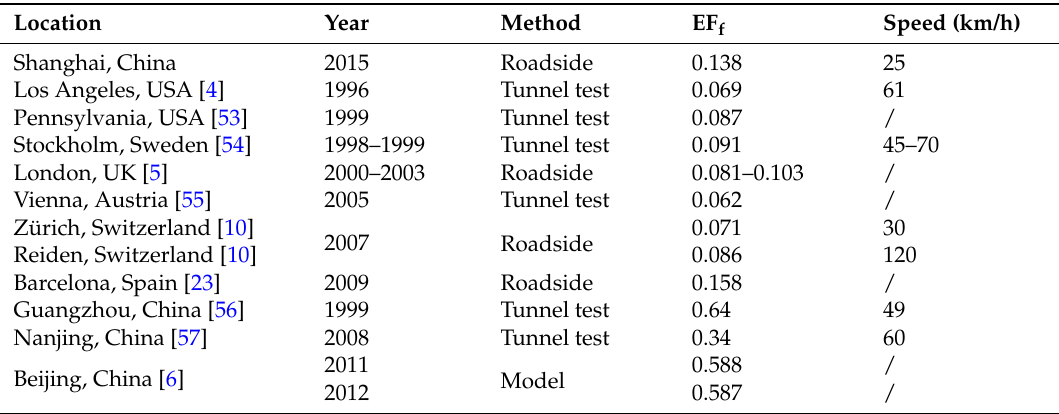
Table 5. Comparison of the fleet-averaged PM 10 emission factor with previous studies